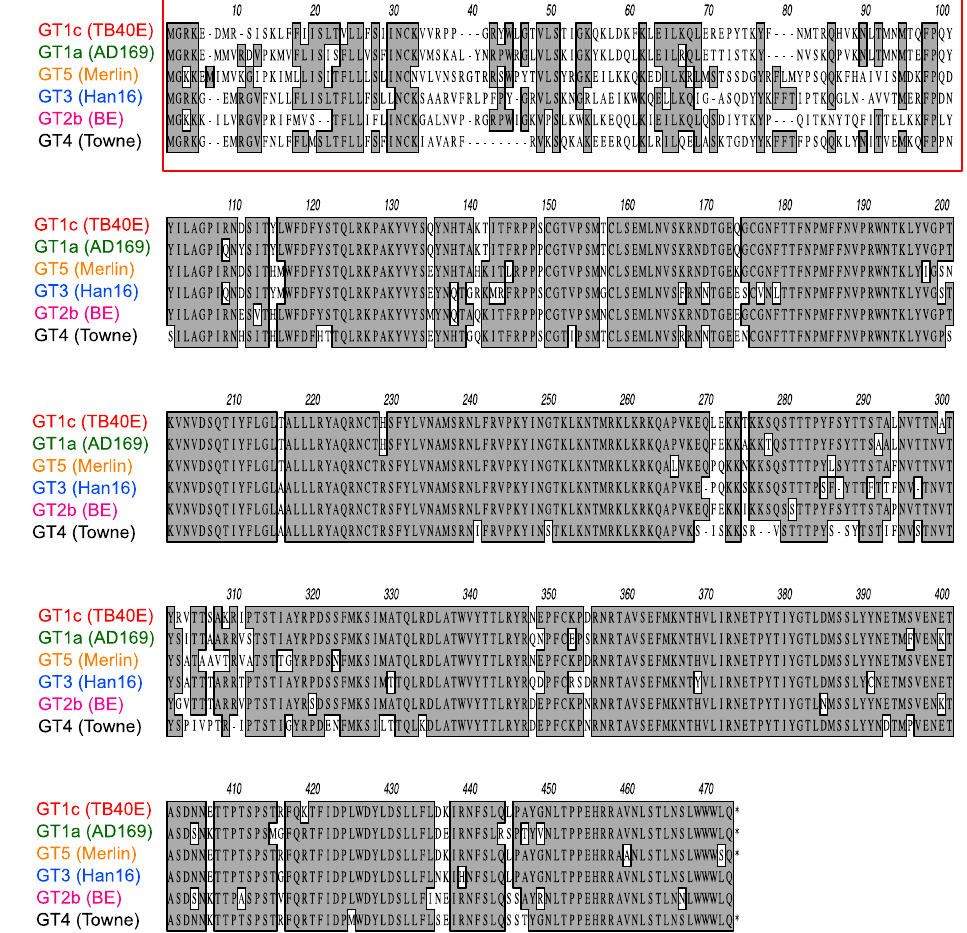
Figure 4. Polymorphisms of gO amino acid sequences encoded by diverse CMV strains. Predicted gO amino acid sequences from CMV strains TB40/E, AD169, Merlin, Han16, BE/29/2011, and Towne were aligned using clustalW. Numbers refer to amino acid positions in Merlin gO; the red box indicates the most highly polymorphic region.